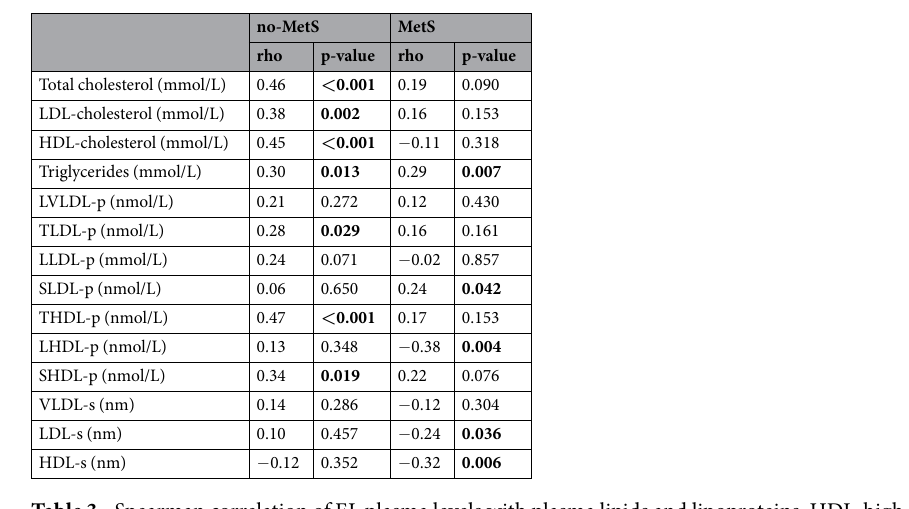
Table 3. Spearman correlation of EL plasma levels with plasma lipids and lipoproteins. HDL-high density lipoprotein; LDL-low-density lipoprotein; LVLDL-p –large very low-density lipoprotein particle; TLDL-p –total LDL particles; LLDL-p –large LDL particles; SLDL-p –small LDL-p; THDL-p –total HDL-particles; LHDL-p –large HDL-p; SHDL-p –small HDL-p; VLDL-s –VLDL size; LDL-s –LDL size; HDL-s –HDL size. Significant associations are depicted in